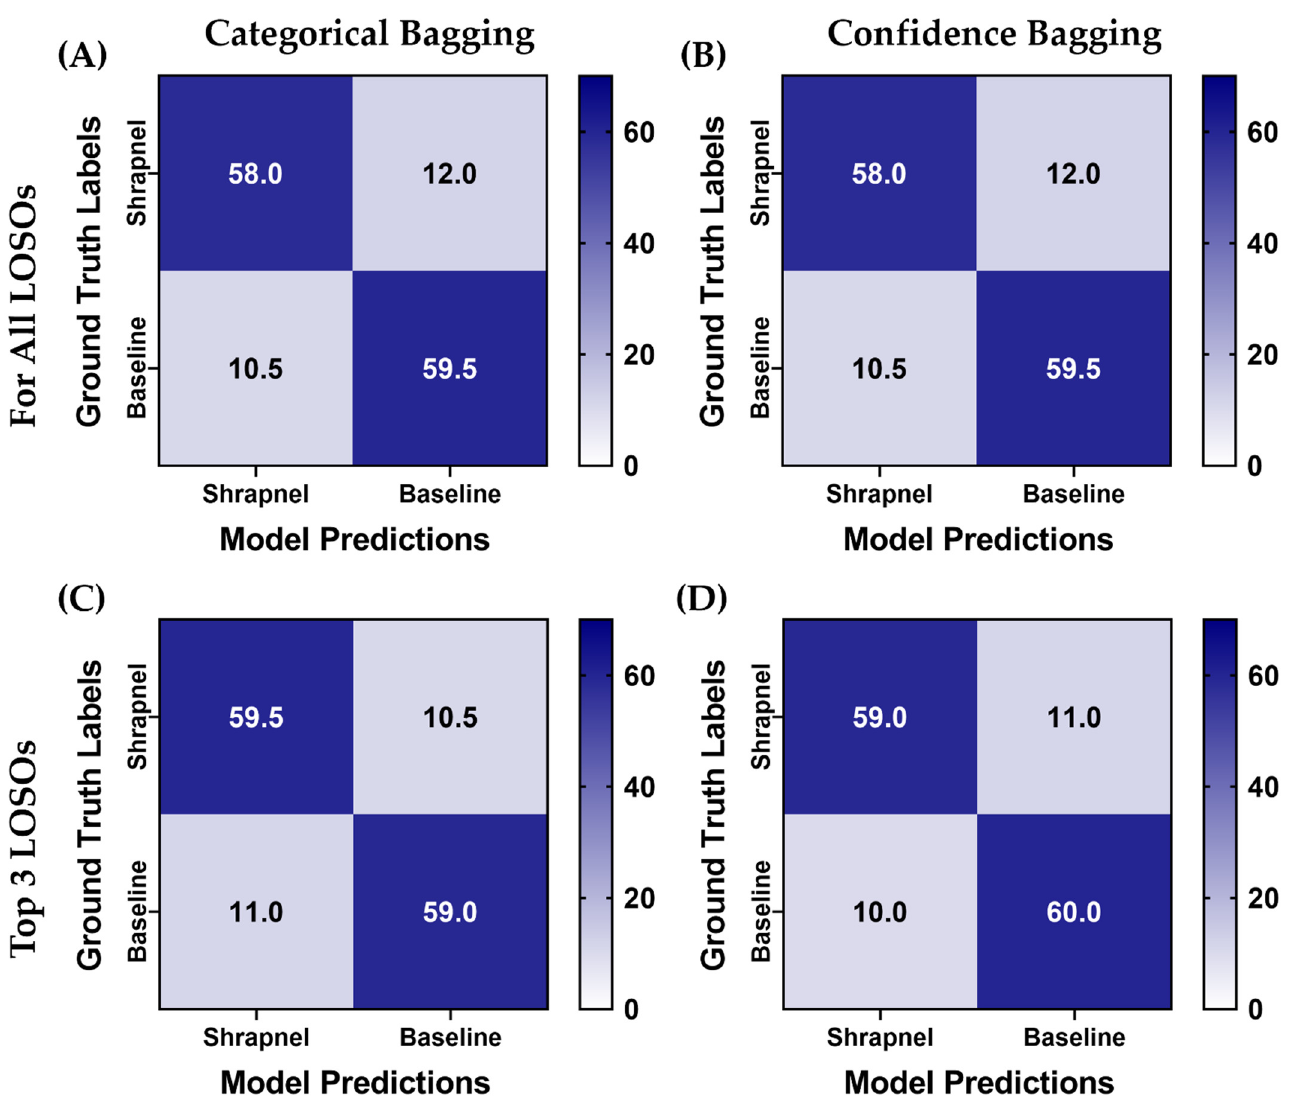
Figure 7. Blind testing performance for affine augmentation-only ShrapML trained models using various ensemble prediction bagging approaches. Average confusion matrices are shown for two blind test image sets for ( A ) categorical and ( B ) confidence ensemble bagging for all five LOSO holdout models. ( C ) Categorical and ( D ) confidence ensemble bagging using the Top 3 confidence models for each prediction. A total of 70 shrapnel and baseline images were used for each blind test run. Table 3. Performance metrics for each ensemble method with augmentation + no MixUp ShrapML model architecture. Mean results for two separate blind test subjects are presented. Heat map over- lay is set between the minimum and maximum value for each performance metric.